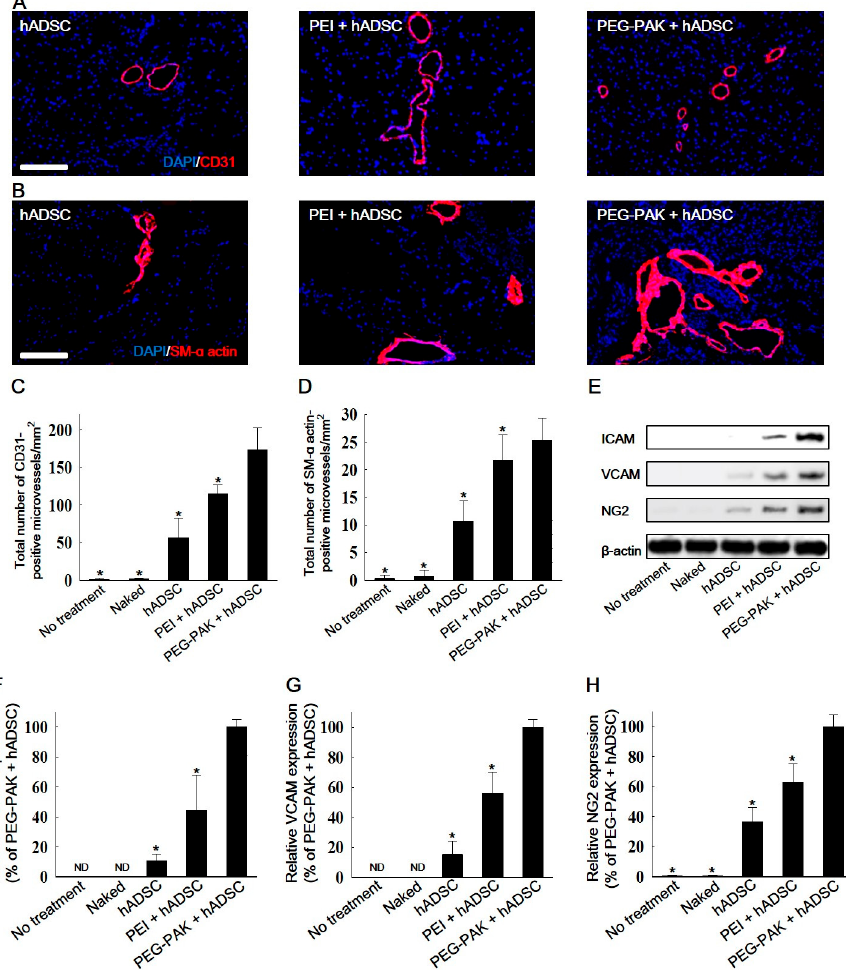
Figure 5. Representative immunohistochemical images of microvessels positive for ( A ) CD31 (red) and ( B ) smooth muscle (SM) α -actin (red) retrieved from hindlimb tissues 21 days after treatment (blue indicates nuclei stained with DAPI, scale bars indicate 100 μ m). Quantification of microvessels positive for ( C ) CD31 and ( D ) SM α -actin in hindlimb tissues (* p < 0.05 compared with PEG-PAK + hADSC group); ( E ) Western blot analysis and quantification of ( F ) ICAM, ( G ) VCAM, and ( H ) NG2 expression in hindlimb tissues at 21 days after treatment. ICAM: intercellular adhesion molecule; VCAM: vascular cell adhesion molecule.